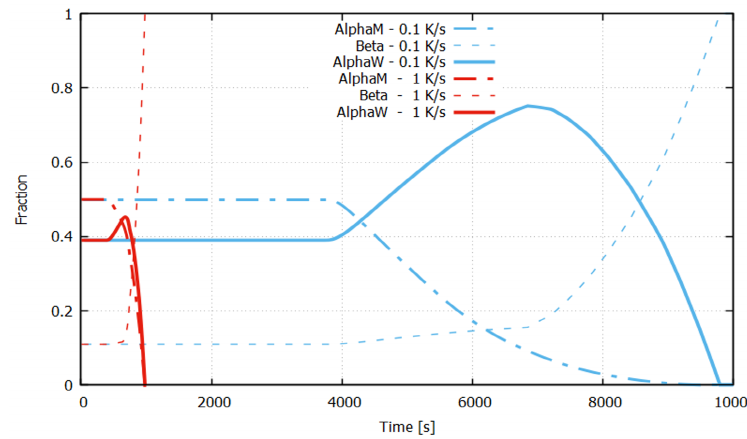
Figure 9. Calculated fraction evolution of Alpha Widmanstatten, Martensite and Beta during continuous heating (0.1–1 K/s).